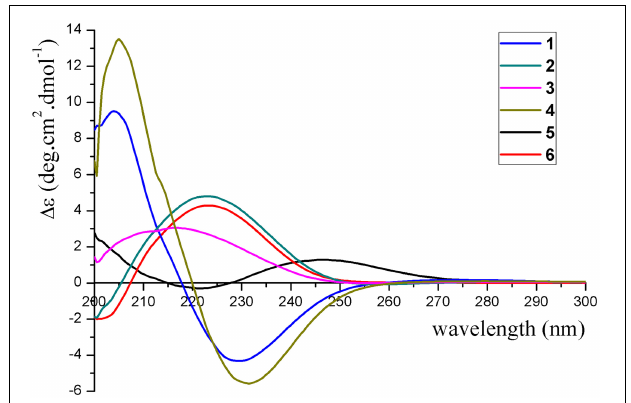
FIGURE 5 | Experimental ECD spectra of compounds 1 – 6